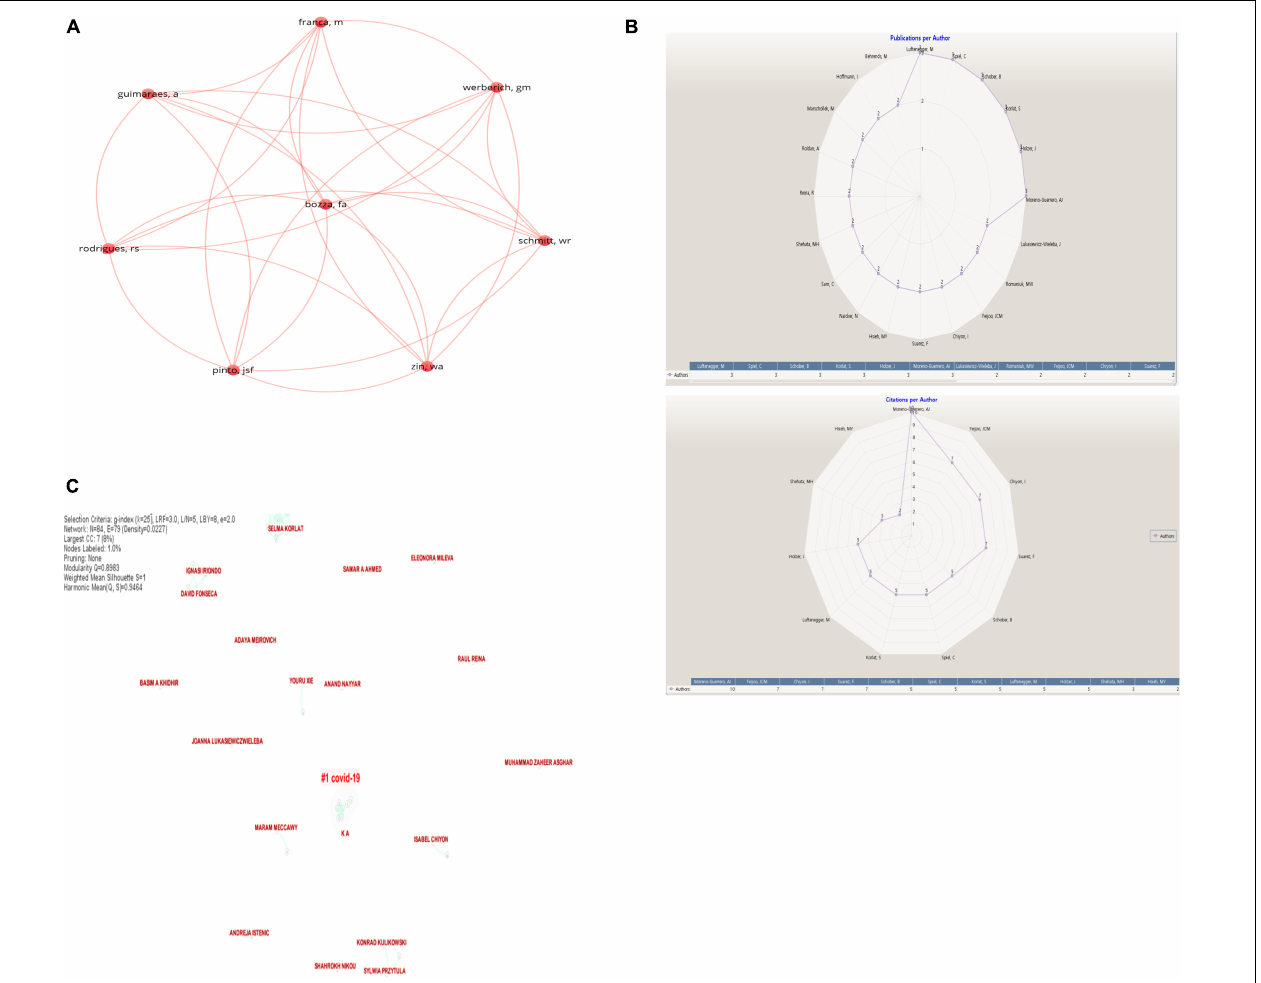
FIGURE 3 | (A) Network of authors (VOSviewer outputs). (B) Publications and citations per author (KnowledgeMatrix Plus outputs). (C) Network of cited authors in COVID-19 (CiteSpace